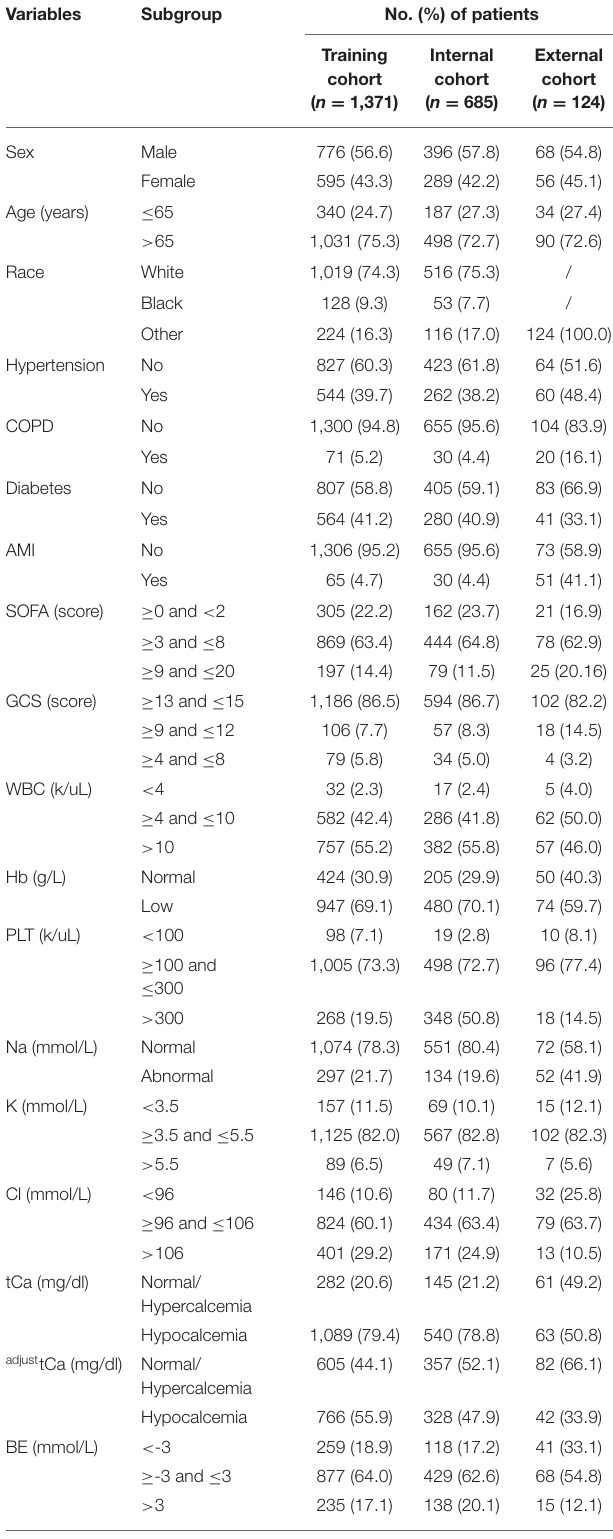
TABLE 1 | The demographic characteristics of patients with acute heart failure (AHF) during the first intensive care unit admission. Variables